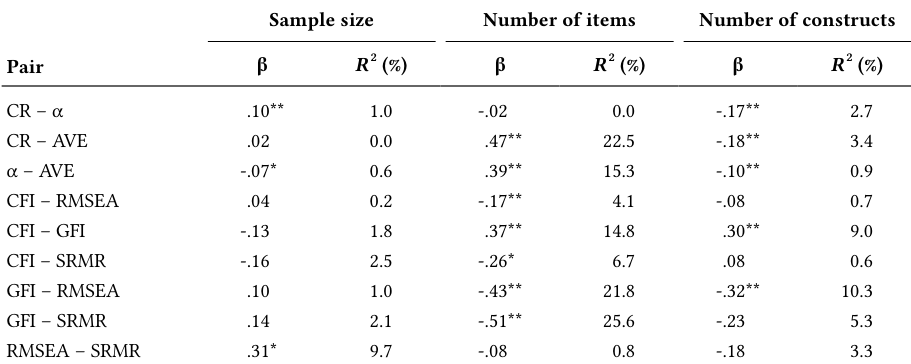
Regression Analysis of Methodological Characteristics and Reliability Indices and Model Fit Metrics Sample